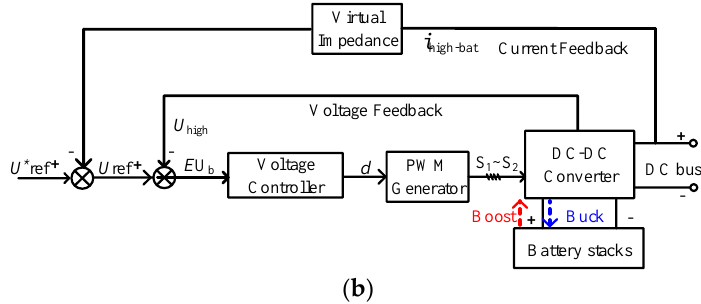
Figure 8. Control strategy for bidirectional power flow; ( a ) virtual capacitor droop (VCD) control; ( b ) virtual resistance droop (VRD) control.